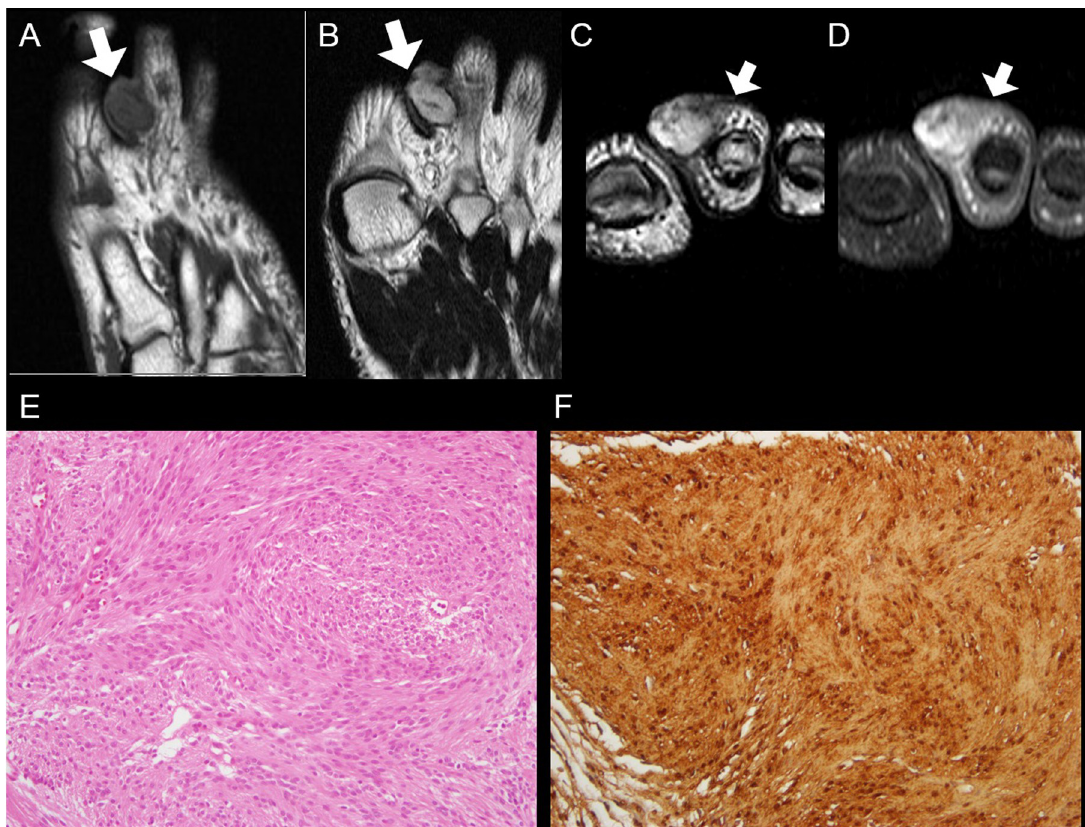
Fig 5. A 54-year old man with digital schwannoma on the dorsomedial side of the 2 nd proximal phalanx of the foot. ( A) On coronal T1-weighted image, the mass demonstrates isointense SI compared to skeletal muscle (arrow). ( B) On coronal T2-weighted image, the lobulated mass reveals heterogeneously hyperintense SI compared to skeletal muscle (arrow). ( C) On axial T2-weighted image, the skin adjacent to the mass shows focal thickening (arrow). ( D) On axial contrast-enhanced T1-weighted image, the mass also reveals heterogeneous enhancement with adjacent skin thickening. ( E) Schwannoma with vague hypo- and hypercellular alterative lesion with no definite nuclear atypia (H&E, X200). ( F) Immunohistochemically (S100X200), tumor cells are strongly positive for S-100 protein. On the pathologic report, skin thickening is noted as inflammatory reactive change without skin invasion. SI , signal intensity.